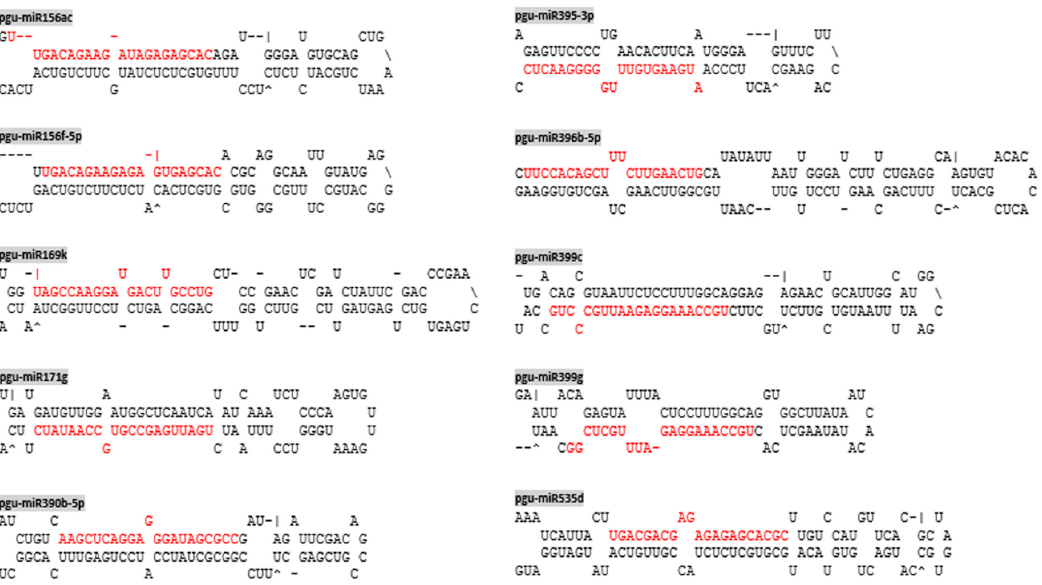
Figure 2. Secondary stem-loop structures of the potential guava miRNA precursors/pre-miRNAs. Respective miRNAs are represented with red font.